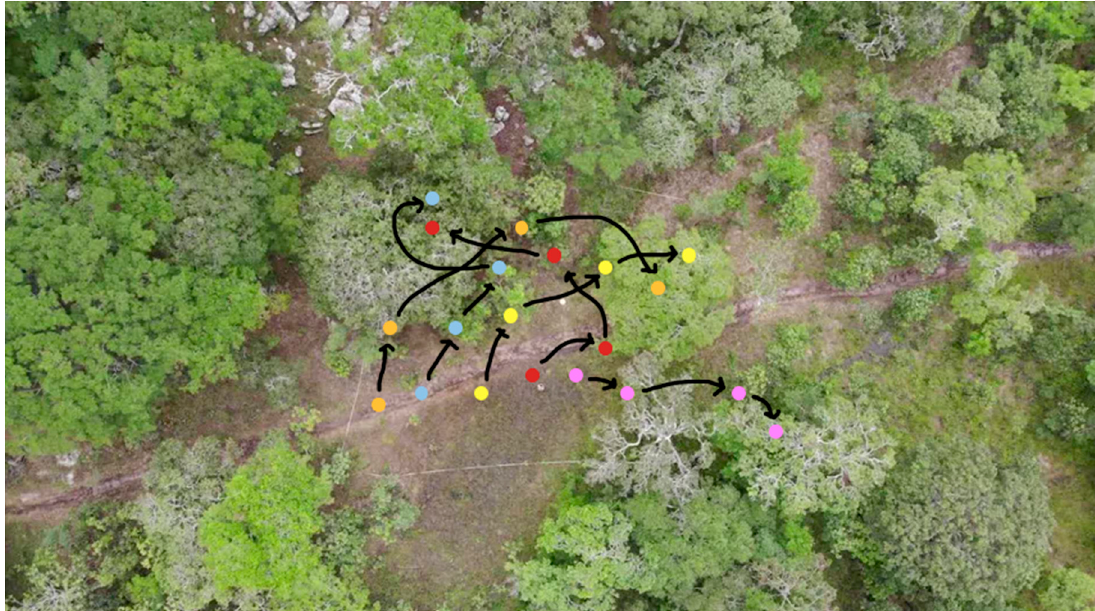
Figure A1. Diagram of the study site and the example locations. The white measuring tape indicates the boundaries of the study site (30 × 30 m). The different coloured spots represent the different sequences of locations. The arrows indicate where the test subject was instructed to walk; they then repeated this same walk backwards.